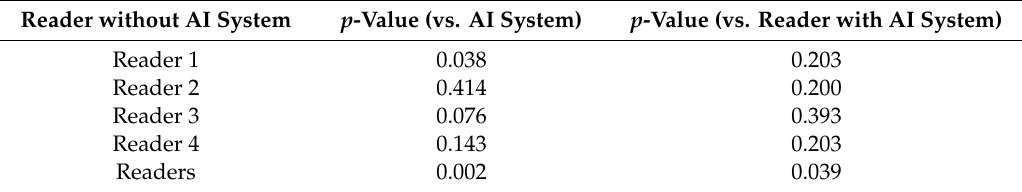
Table 4. Statistical Analysis of the AUCs of Human Readers and AI.